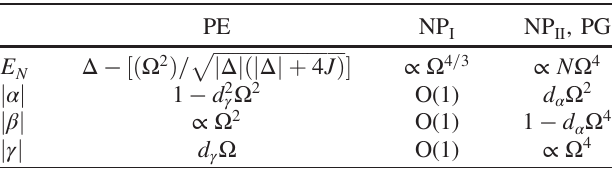
TABLE I. Scaling analysis of the relevant properties of EBS for the regimes with Ω ≪ W depicted in Fig. 2.